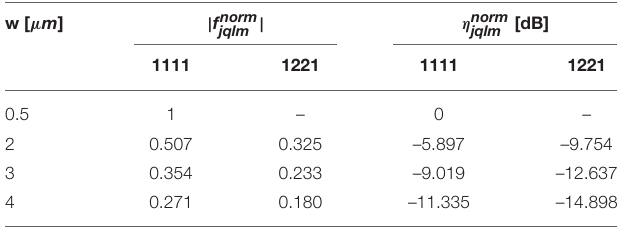
TABLE 2 | Normalized mode field overlap and normalized efficiency for various waveguide widths and h = 300nm, h s = 190nm, h clad = 900nm and h sub = 2 µ m [see Figure 1 (left) for the meaning of the parameters].